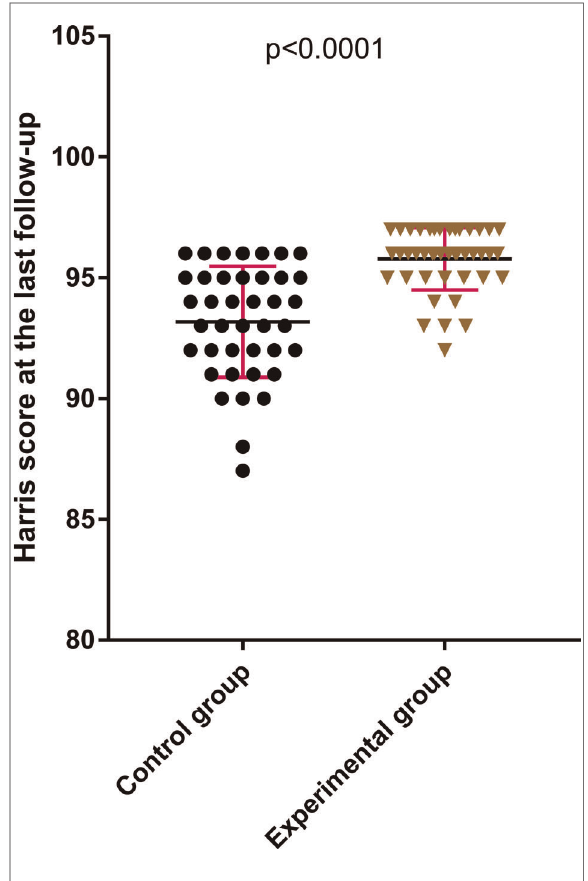
FIGURE 5 The last Harris score of the hip joint in the experimental group is better than that in the control group.